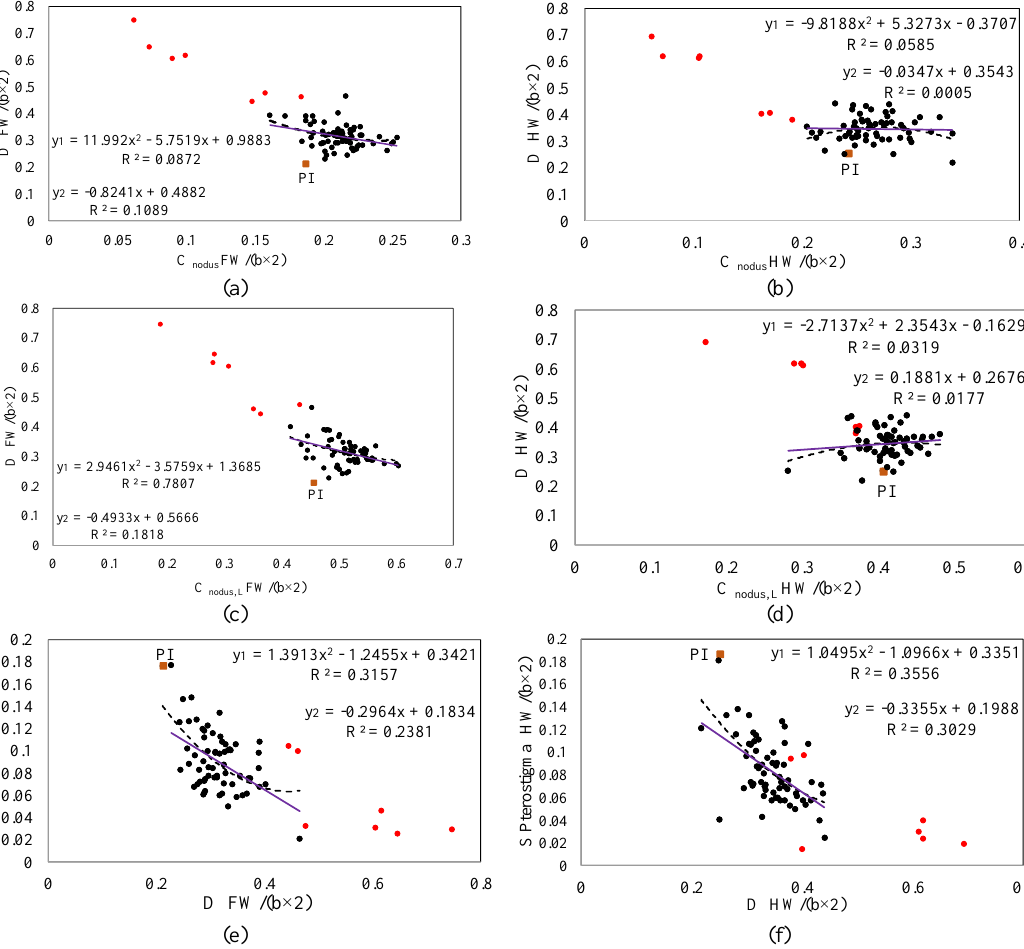
Table 1. Essential wing geometrical parameters exported from the graphs.